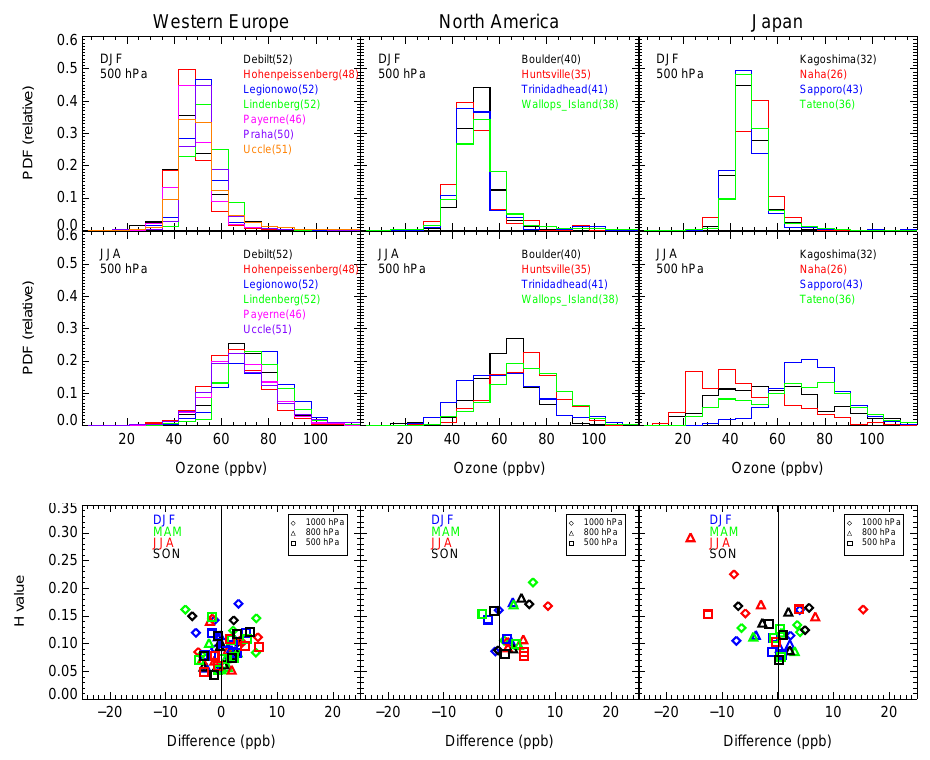
Fig. 6. First and second row: probability distribution function (PDF) of ozone at 500hPa for different stations in Western Europe (left), US (middle), and Japan (right), and for winter (top row) and summer (middle row). Bottom row: Hellinger distance between the ozone distribution of single stations (shown on the top) and the regionally aggregated distribution versus the median differences of the two distributions, for three altitude levels (different symbols) and 4 different seasons (winter: blue, spring: green, summer: red, fall: